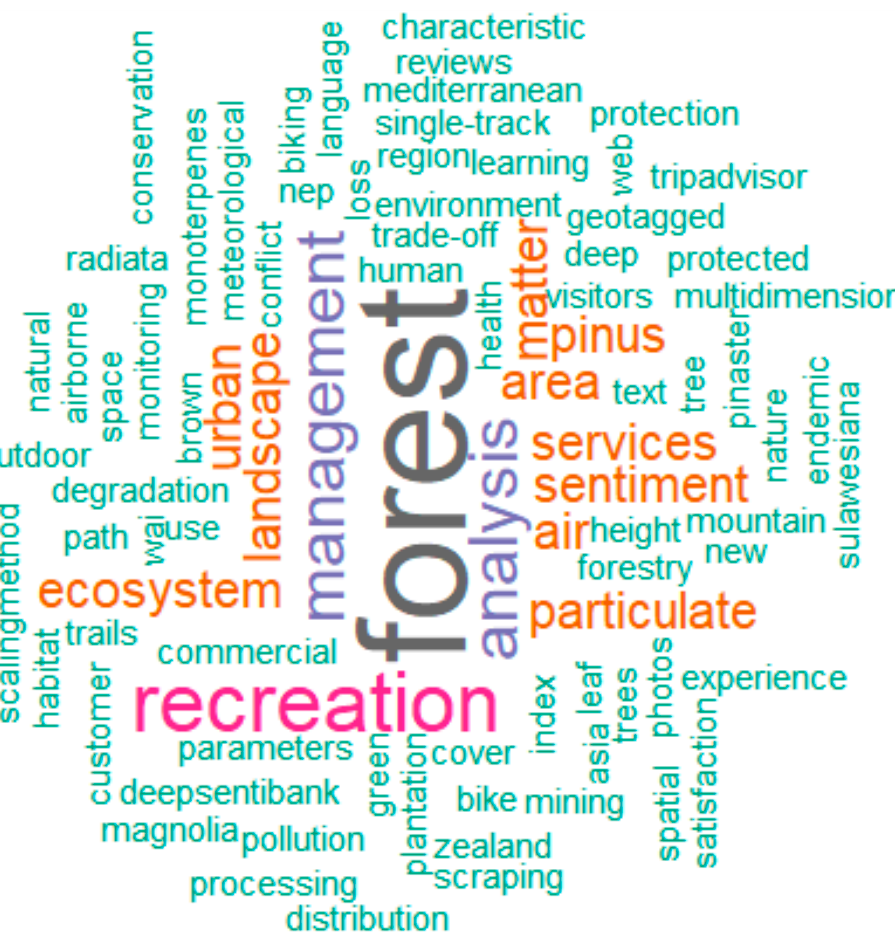
Figure 3. Keywords of the papers in this Special Issue. Data source: [1–10].